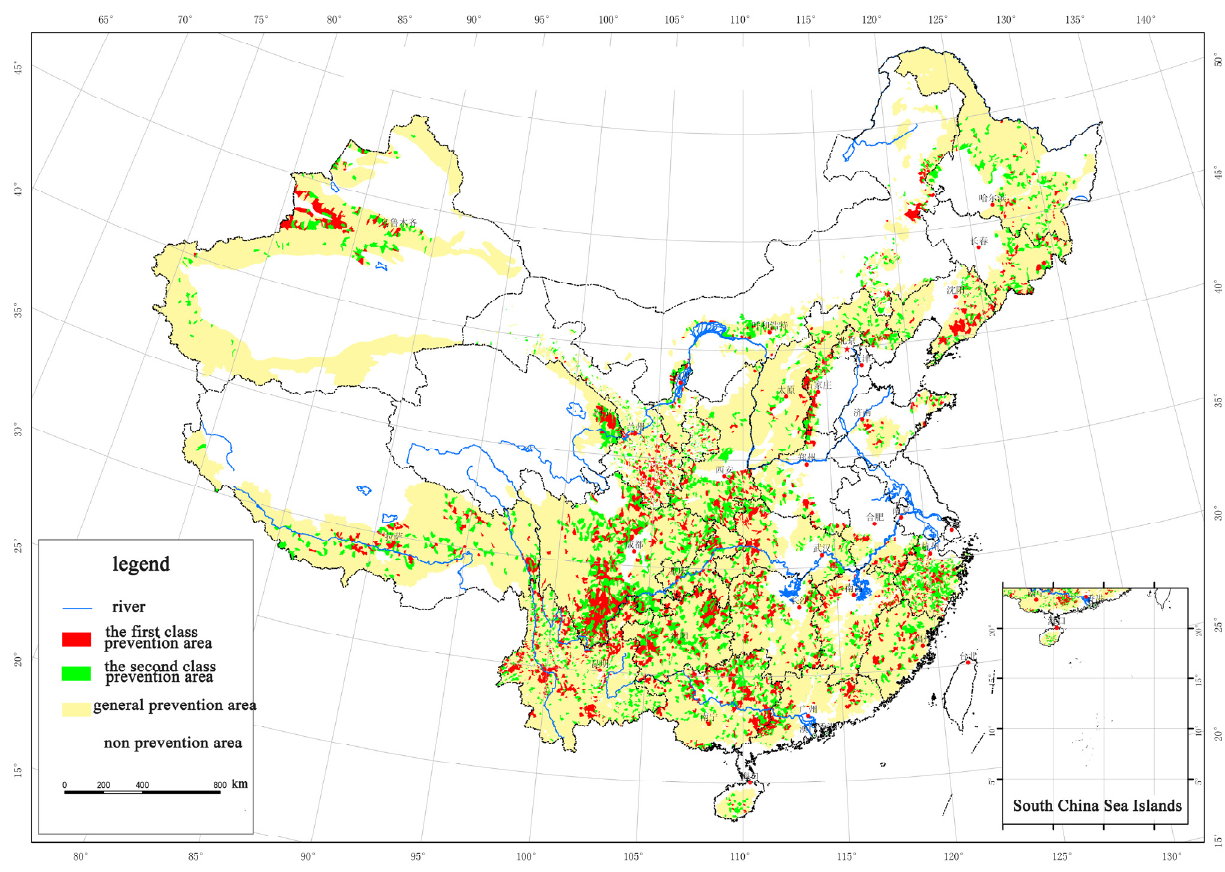
Figure 1. Zoning map of prevention area of flash flood disasters in